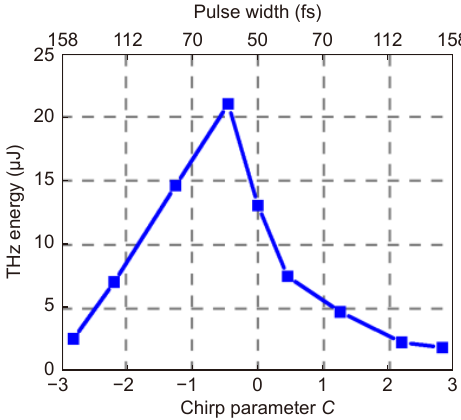
Fig. 2 | Pulse energy of THz radiation generated by femto- second laser with different frequency chirps (bottom axis) and different pulse widths (top axis) in